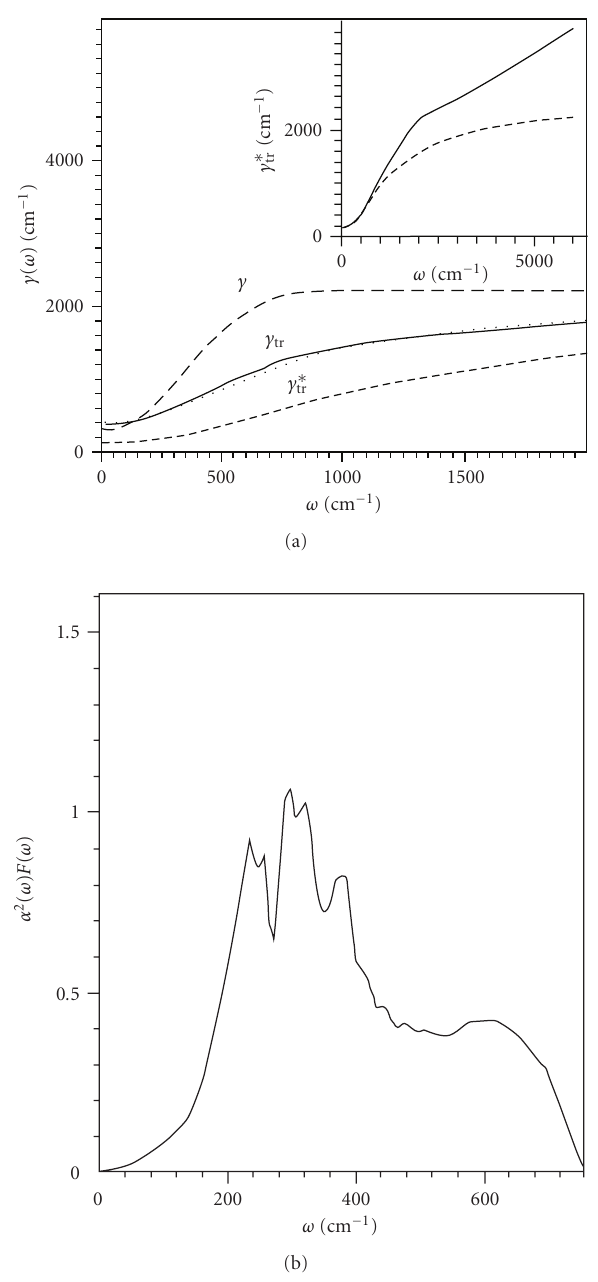
Figure 4: (a) Scattering rates γ ( ω , T ), γ tr ( ω , T ), and γ ∗ —from top tr to bottom—for the Eliashberg function in (b). From [33–35]. (b) ( ω ) F ph ( ω ) obtained from tunnelling Eliashberg spectral function α 2 ep with (full experiments on break junctions [42–45]. Inset shows γ ∗ tr line) and without (dashed line) interband transitions